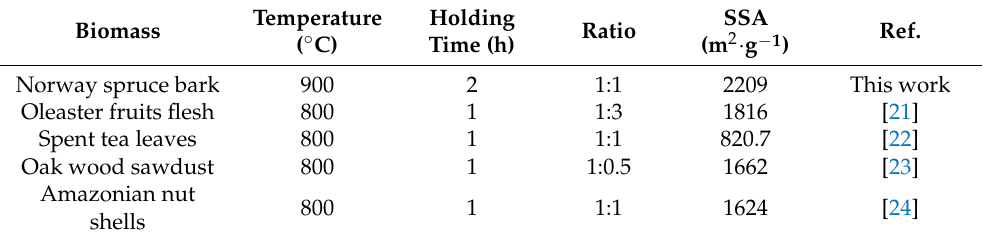
Table 2. Short literature review of ACPB preparation and SSA values.